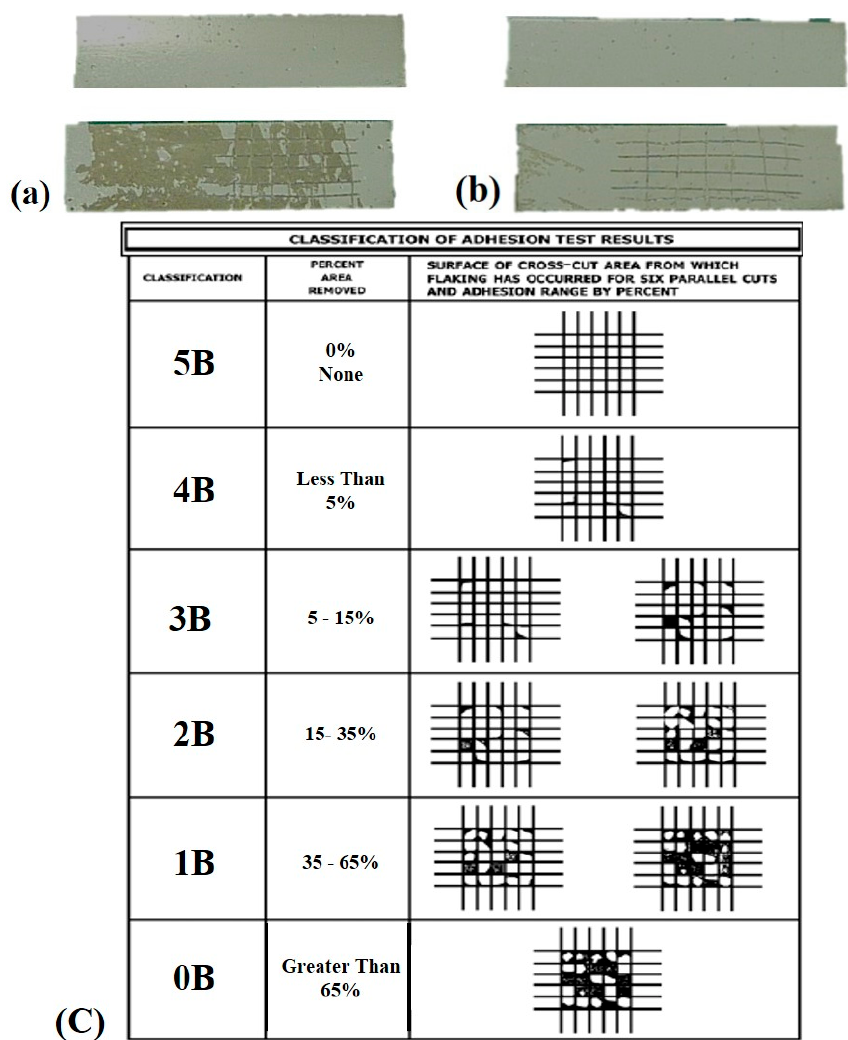
Figure 5. Results of adhesion test of the Zr-based MGTF coating on the Mg-based BMGC with different buffer layers; ( a ) with Film A coating; ( b ) with Film B coating. ( c ) Classification of adhesion test results (ASTM D3359-09) [29].